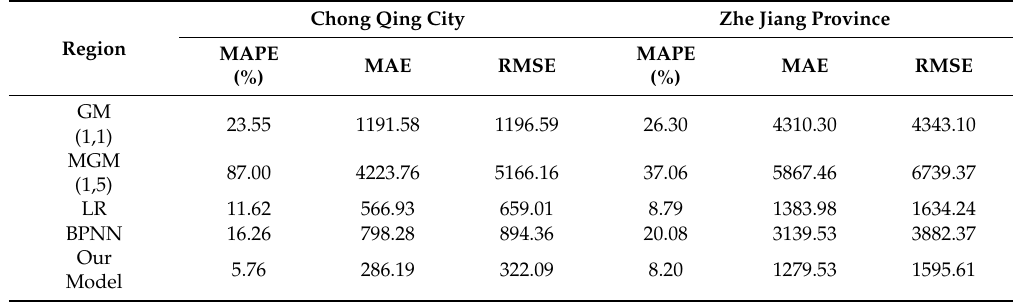
Table 5. Evaluation results for di ff erent predictive models on the statistical data of Zhe Jiang province and Chong Qing city in China.